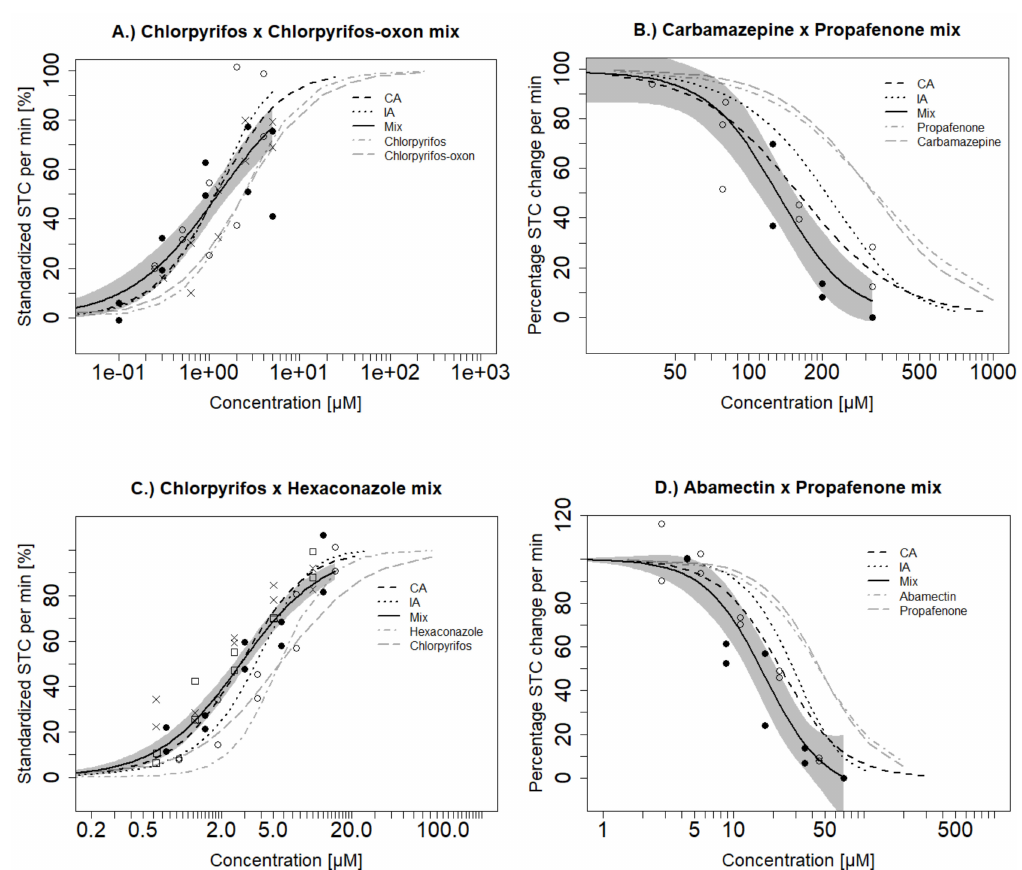
Figure 3. Comparison of observed (Mix) versus predicted effects of binary mixtures based on the concentration addition (CA) and independent action (IA) models in the STC. Furthermore, mixture effects are compared to single substances effects: ( A ) Hyperactivity Mixture A; ( B ) Hypoactivity Mixture A; ( C ) Hyperactivity Mixture B; ( D ) Hypoactivity Mixture B. Grey shaded areas represent the confidence interval of the fitted mixture model for the observed effect. Different symbols represent the observed mean of the STC effect for 20 embryos exposed in independent mixture